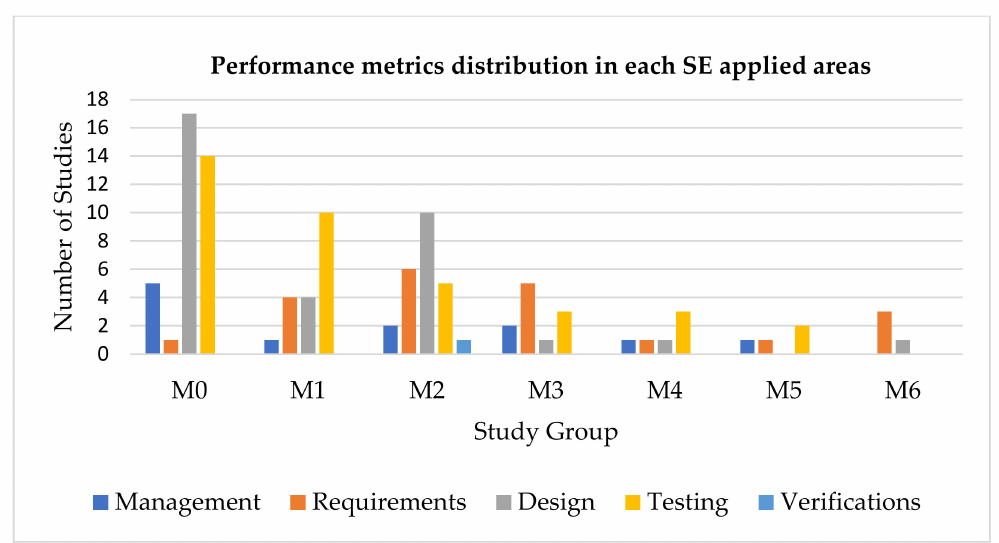
Figure 14. SE applied areas over the study